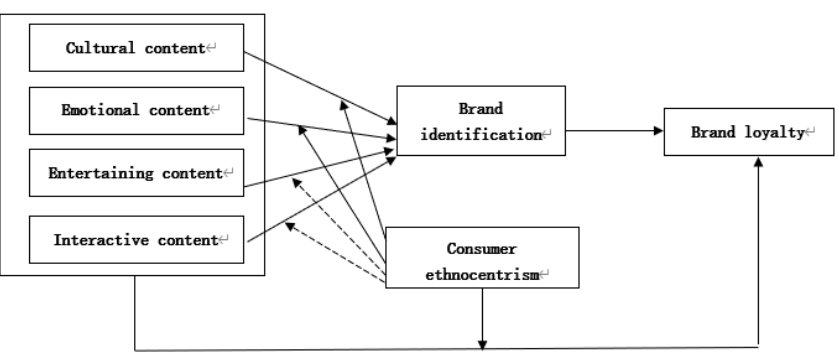
Figure 2: Theoretical analysis framework of the relation between content marketing and brand loyalty for “New Guochao” brands Questionnaire Design and Empirical